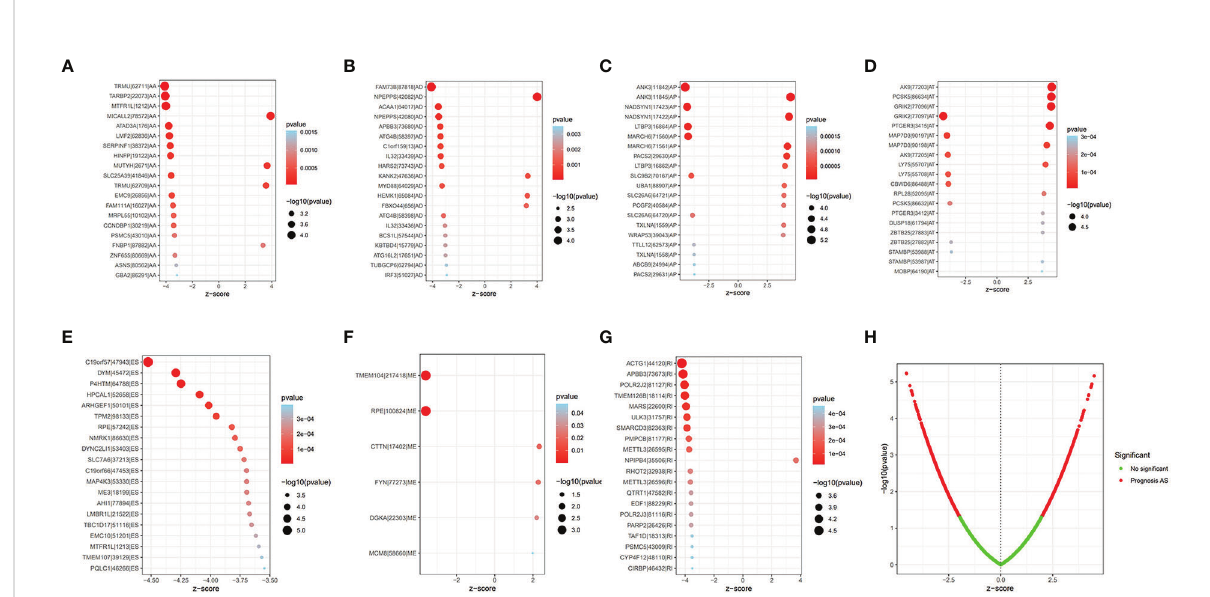
FIGURE 1 The prognostic AS events. (A – G) The bubble plot of the 20 most relevant prognostic AS events in different types of AS events, except ME. (H) The volcano plots of prognostic AS events. AS, alternative splicing; ME, mutually exclusive